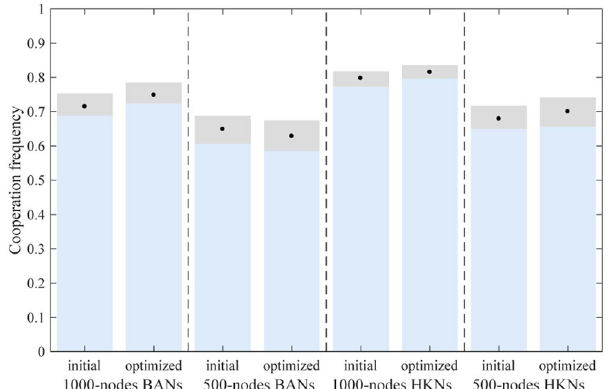
Figure 3. Simulation results of EA cluster in optimizing population structure for the promotion of cooperation in PDG. Each group contains 10 independent structures whose evaluated cooperation level lies within a gray bar (black points mark the mean value). On the whole, naively optimizing the clustering coefficient of a population structure may promote cooperation in PDG, but it is not efficient enough. Moreover, sometimes this method may fail and produce a worse structure, as shown in the optimization of 500-node BANs (the mean value gets